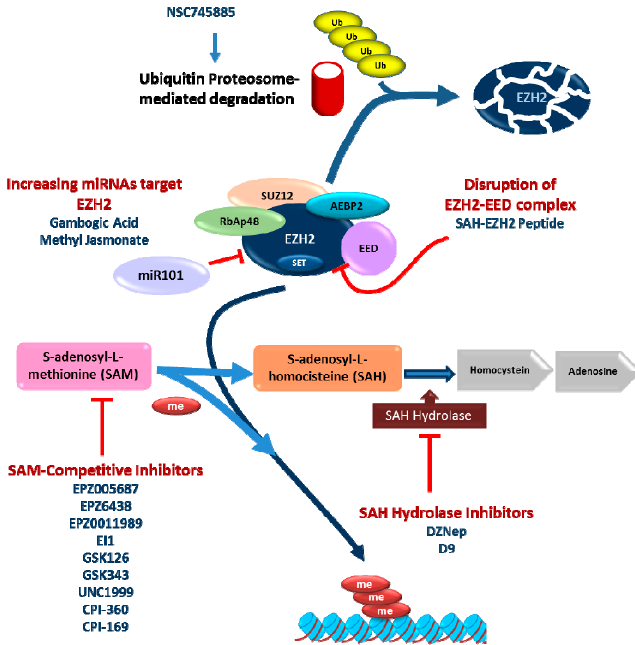
Figure 3. Inhibitors developed against EZH2. The five types of inhibitors are indicated: “ S -adenosyl- L -homocysteine hydrolase inhibitors”, “ S -adenosyl- L -methionine competitive inhibitors”, “ S -adenosyl- L -homocysteine-EZH2 peptides as disruptors of the contact between EZH2 and EED”, “Degradation by ubiquitin proteasome pathway”, and “Downregulation mediated by the increased expression of miRNAs target of EZH2”. EZH2: Enhancer of zeste homolog 2. SUZ12: Zinc finger protein suppressor of zeste 12. EED:WD40 Repeat protein embryonic ectoderm development. SET: Su(var)3-9E Enhancer of zeste and Trithorax RbAp48: Retinoblastoma-binding protein p48. AEBP2: Adipocyte Enhancer-Binding Protein 2. DZNep: 3-dezaneplanocin-A Me: methylation. Ub: ubiquitination Mir101: miRNA-101. Arrow blue: activation of different pathways Arrow red: inhibition of different molecules. Light blue cylinders are histones, and with red ribbons are DNA.